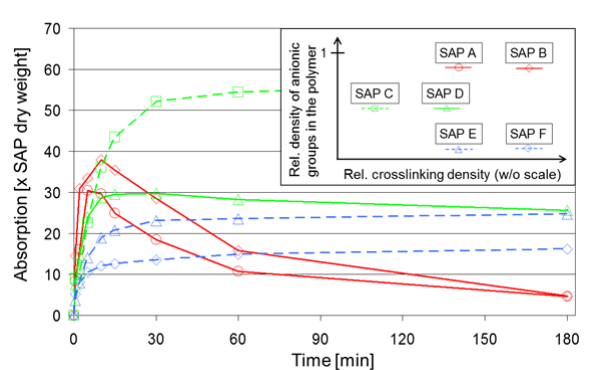
Figure 2. Absorption of different SAP materials in cement pore solution, after